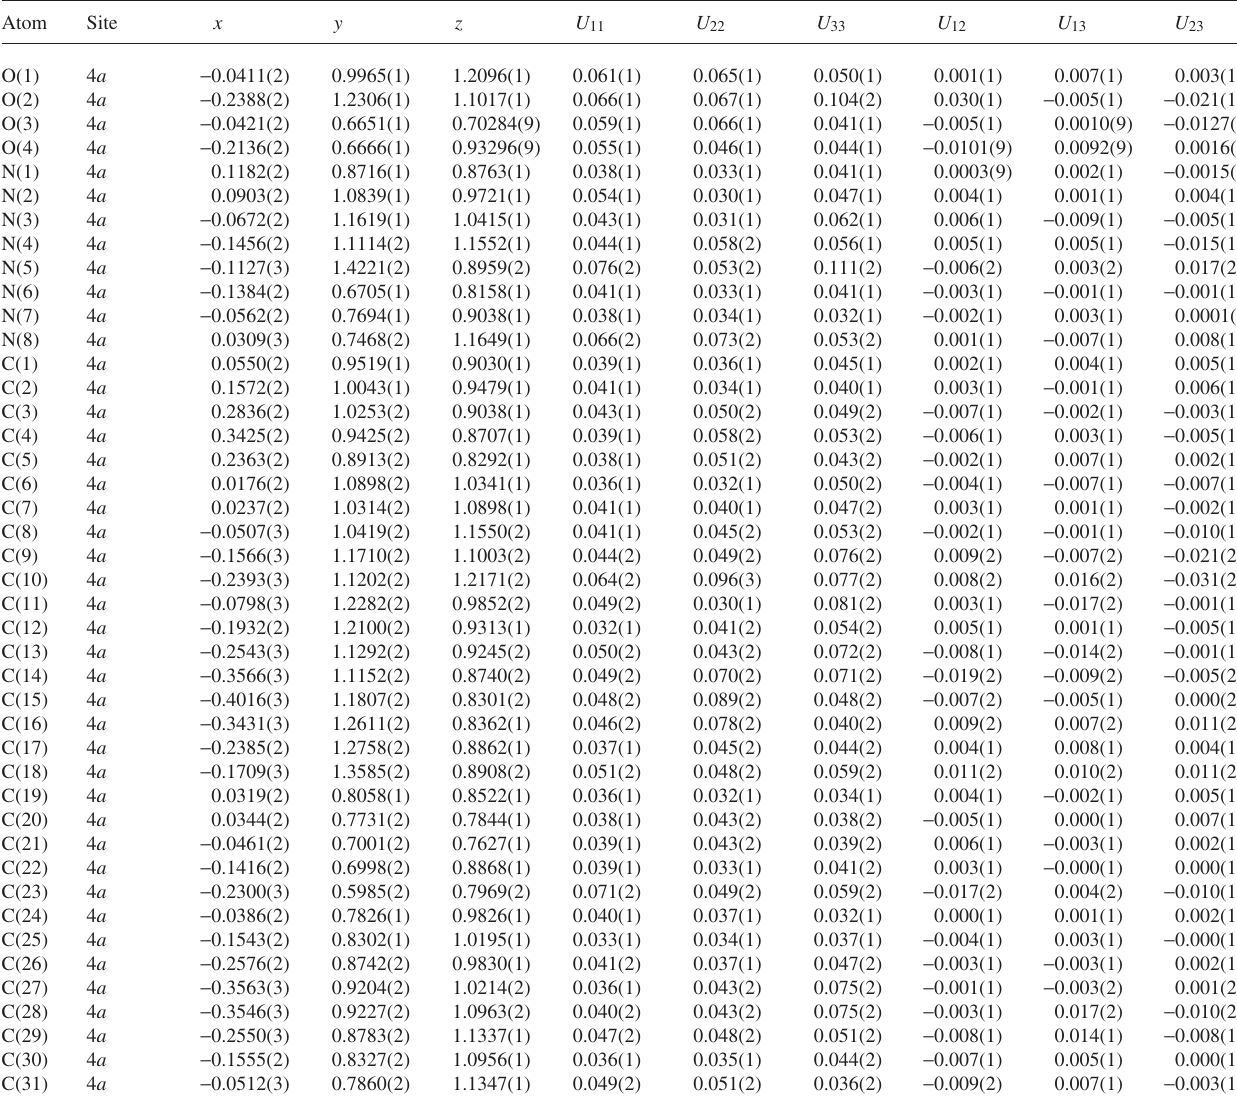
Table 3. Atomic coordinates and displacement parameters (in Å 2 )